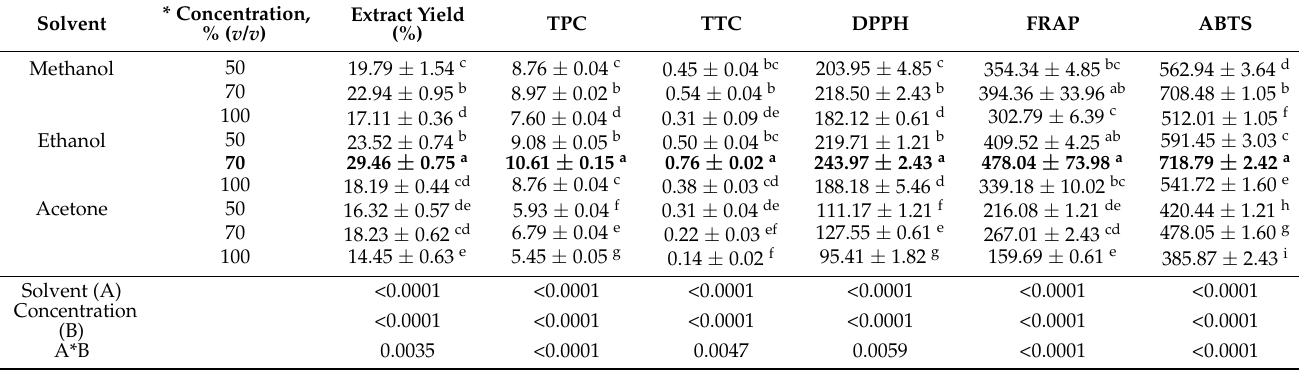
Factorial ANOVA was performed for Factor A (solvent) and Factor B (concentration). Values are means ± SE of triplicate ( n = 3) determinations. Different letter(s) in each column indicate statistically significant ( p < 0.05) differences according to Duncan’s